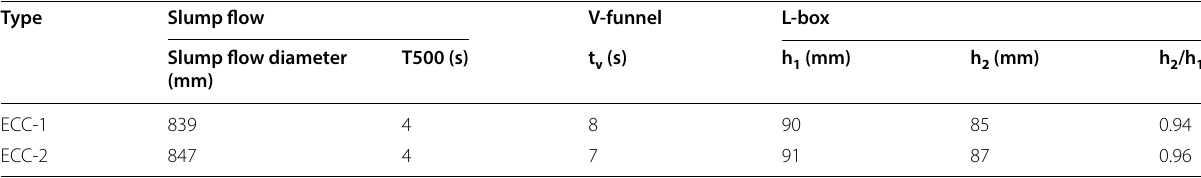
Table 3 Fresh SC-ECC test results.